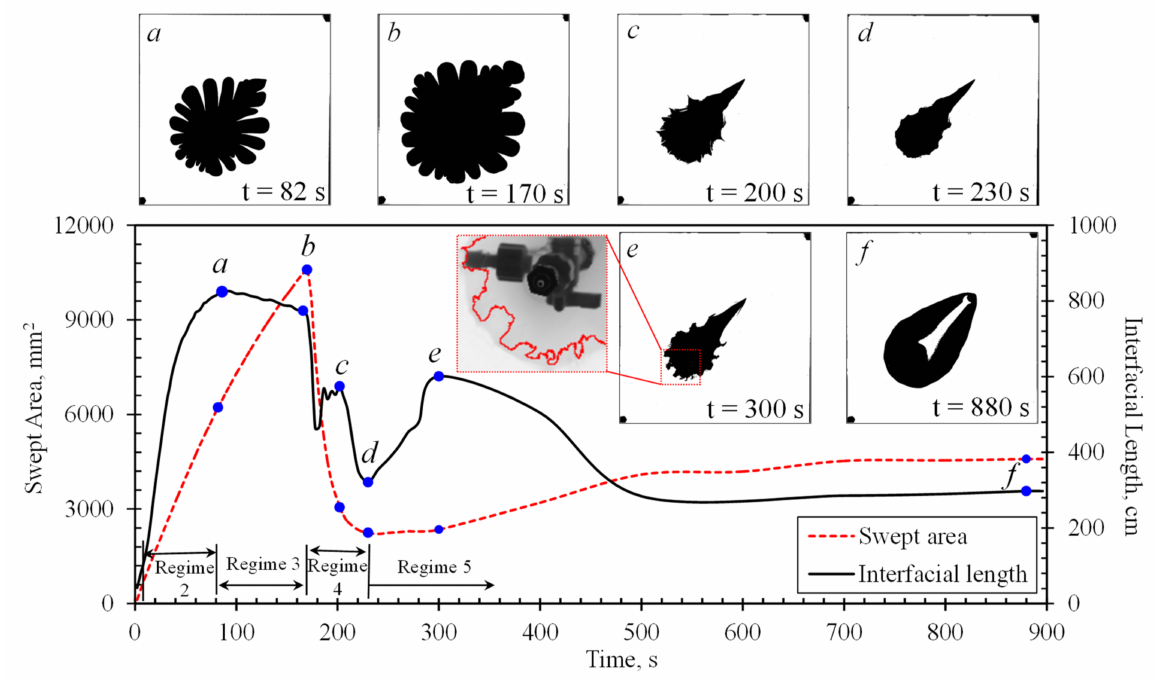
Figure 3. The swept area and interfacial length of water plume for 5.0 mL/min. Fingering outlines are plotted for each